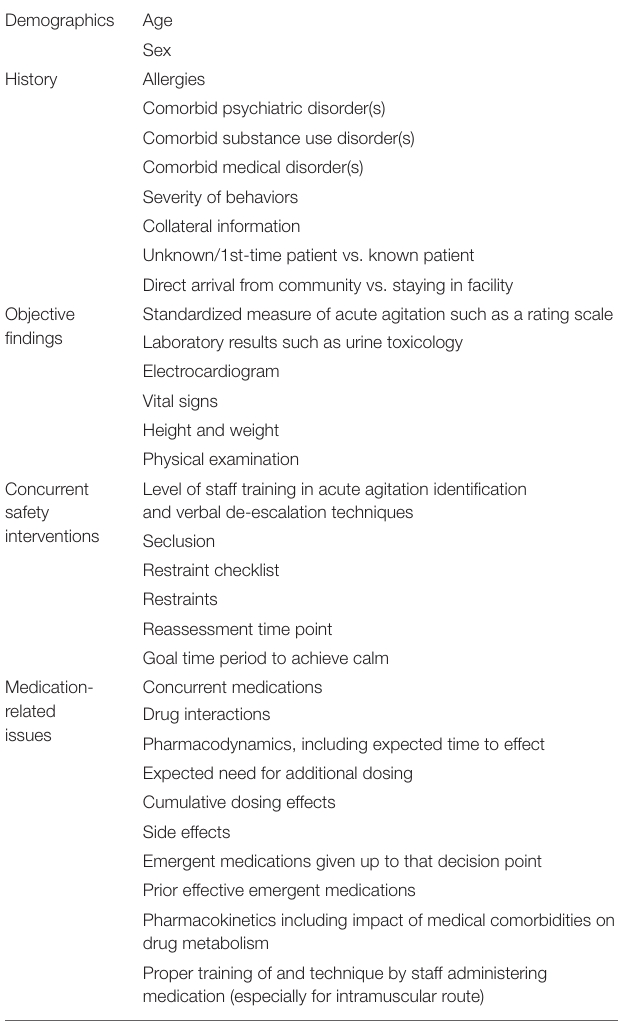
TABLE 2 | General considerations when selecting emergent medications for repeated